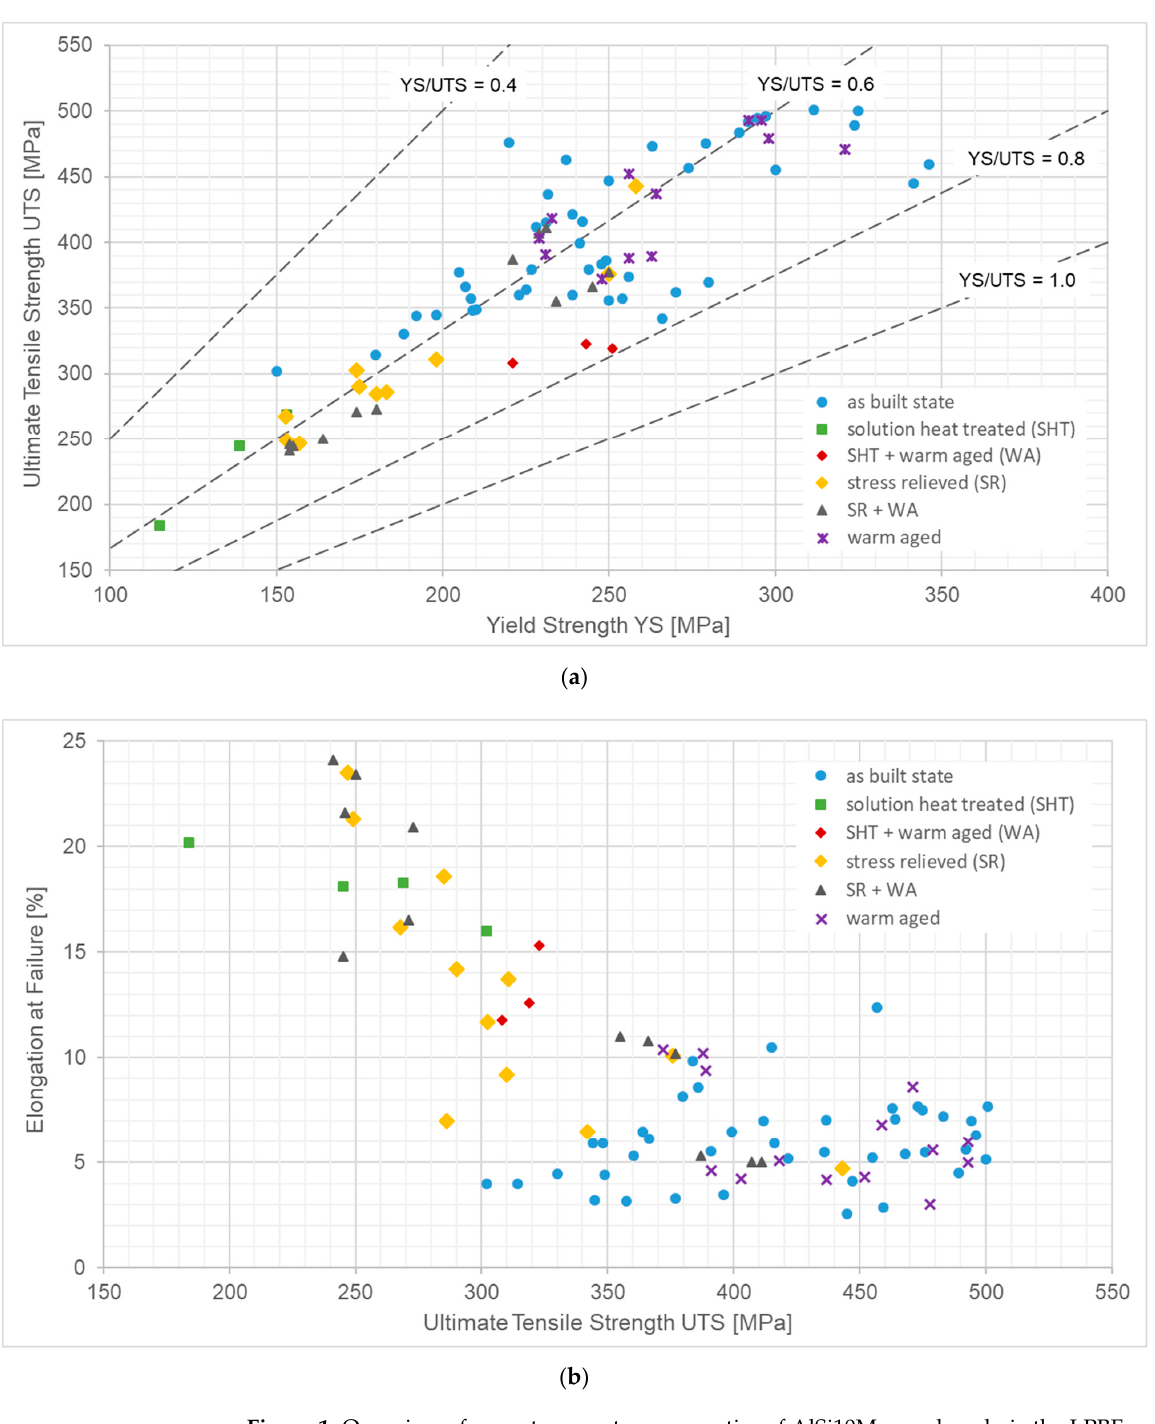
Figure 1. Overview of room temperature properties of AlSi10Mg produced via the LPBF process as reported in the scientific literature [16,18,21,22,26–39]: ( a ) ultimate tensile strength (UTS) plotted vs. yield strength (YS), and ( b ) elongation at failure plotted vs. UTS. The data cover different printing directions, process parameters and heat treatment states, namely as-built (AB), stress-relieved (SR), solution heat-treated (SHT) and warm-aged (WA), plus combinations of these. The individual values are presented in Table A1 in Appendix A together with a brief explanation of the respective boundary